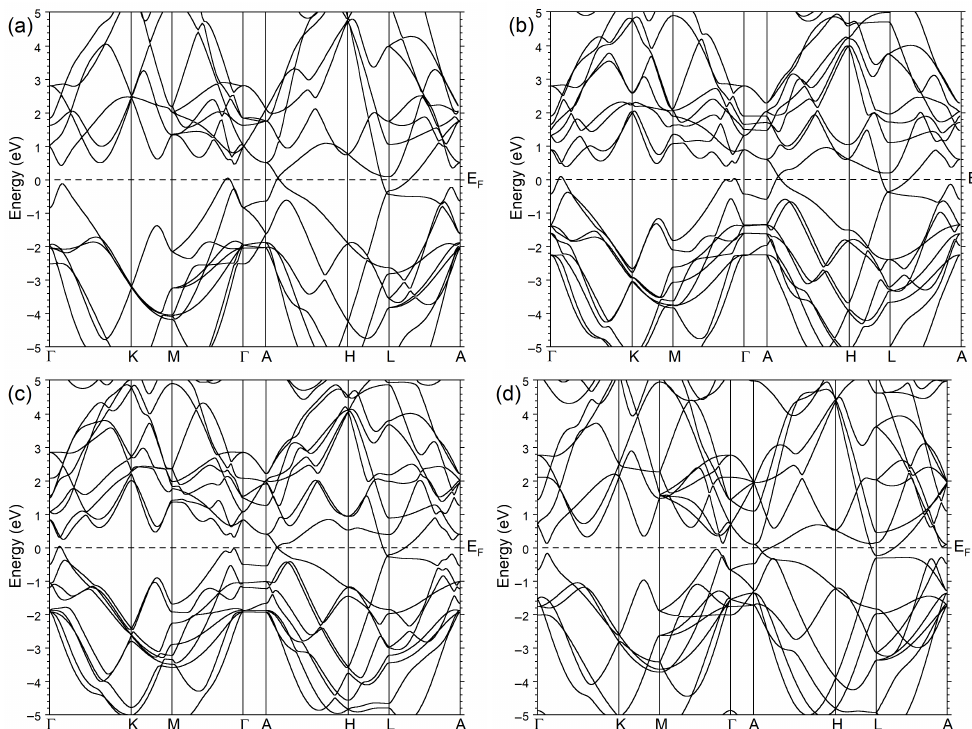
Figure 2. Electronic structure of ( a ) As, ( b ) As 0.67 Sb 0.33 , ( c ) As 0.33 Sb 0.67 , and ( d ) Sb. The Fermi level position, E F , which is set to zero, is marked by horizontal dashed